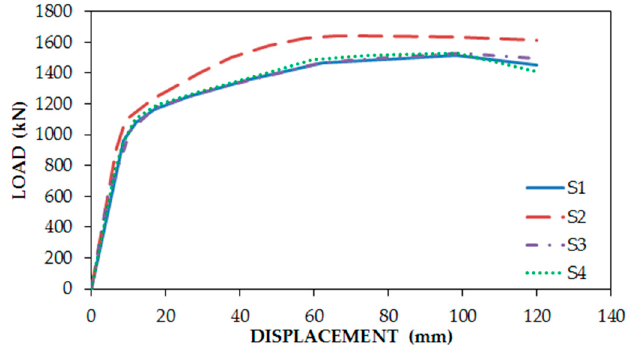
Figure 8. Comparison among backbone graphs of FE models based on the stiffness of the boundary elements. Table 2. Results of models.